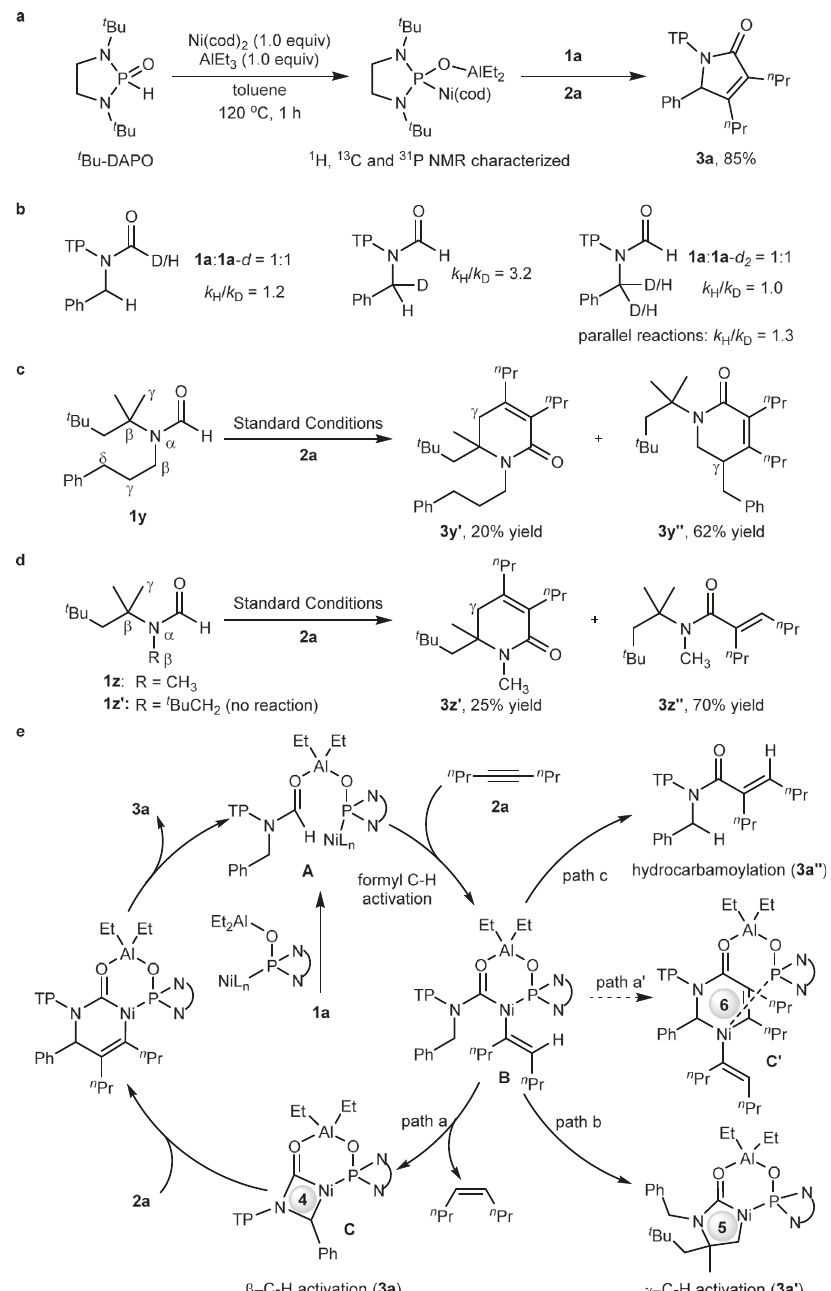
Fig. 5 | Mechanistic experiments. a t Bu-DAPO – Ni – Al complex preparation and reactivity. b KineticisotopeeffectofformylC – Hbond(left),andintra-(middle)and intermolecular(right)kineticisotopeeffectofbenzylicC – Hbond. c 3-Phenylpropyl group instead of benzyl group led to complete γ -C(sp 3 ) – H bond activation,